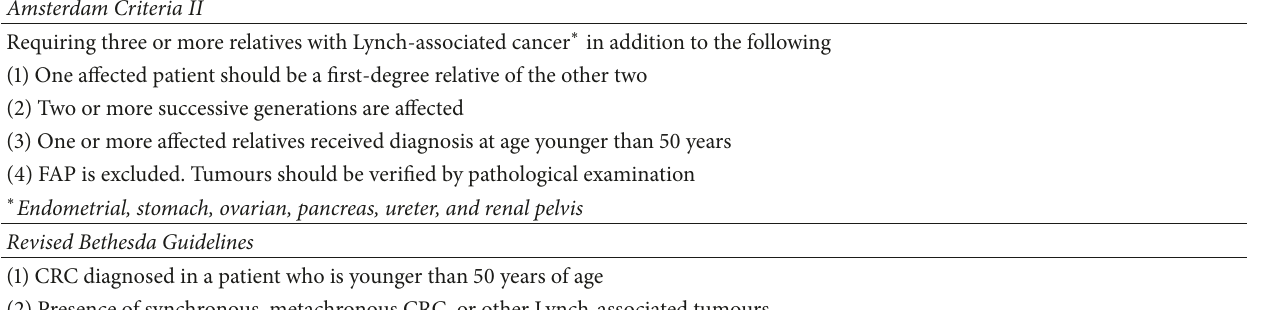
Table 1: Amsterdam II, Revised Bethesda Guidelines, and HCP Referral Criteria. Amsterdam Criteria